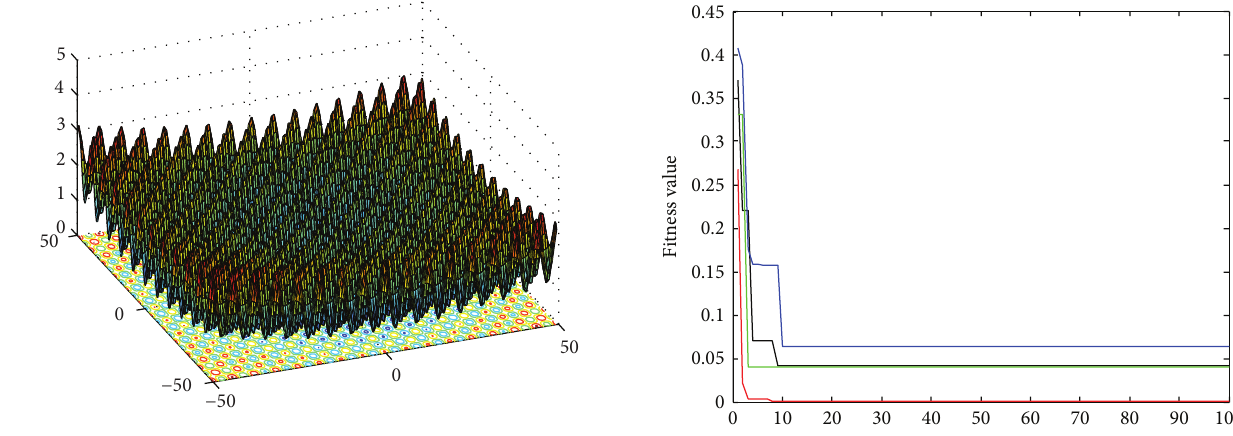
Figure 4: Surface landscape of Griewank function.